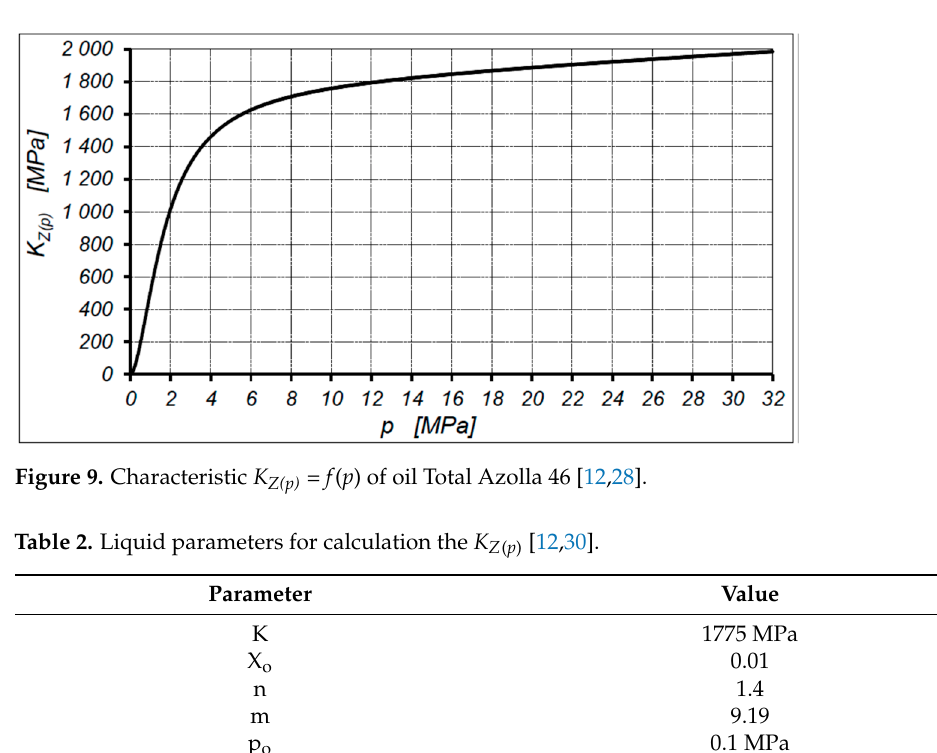
Figure 9. Characteristic K Z(p) = f(p) of oil Total Azolla 46 [12,28].